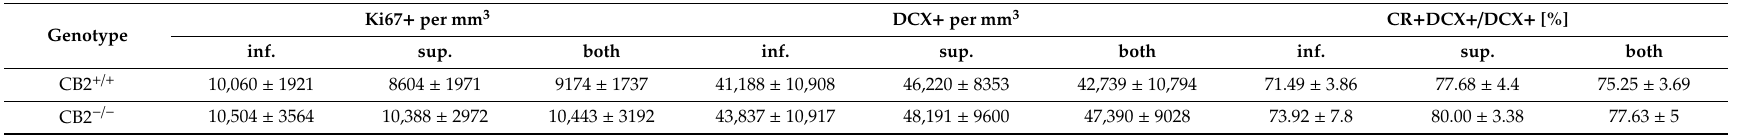
Table 1. Mean ± SD values of Ki67 + and DCX + cells per mm 3 of the granular cell layer and percentage of immature neurons (CR + DCX + ) from all DCX + positive cells in wildtype (CB2 +/+ ) and CB2-deficient (CB2 − / − ) mice and in both blades of the dentate gyrus. inf.—infrapyramidal, sup.—suprapyramidal. Ki67 + per mm 3 CR + DCX +/ DCX + [%] Genotype inf. sup. both inf. sup. both inf. sup.